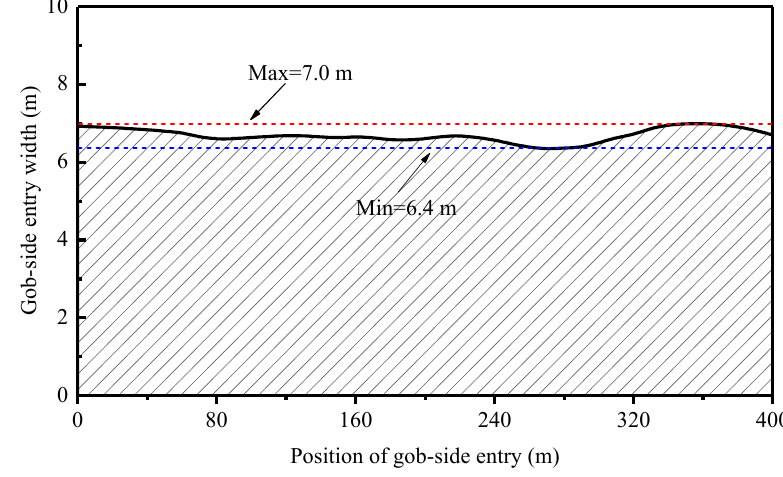
Figure 11. Statistical diagram of the retaining roadway width.